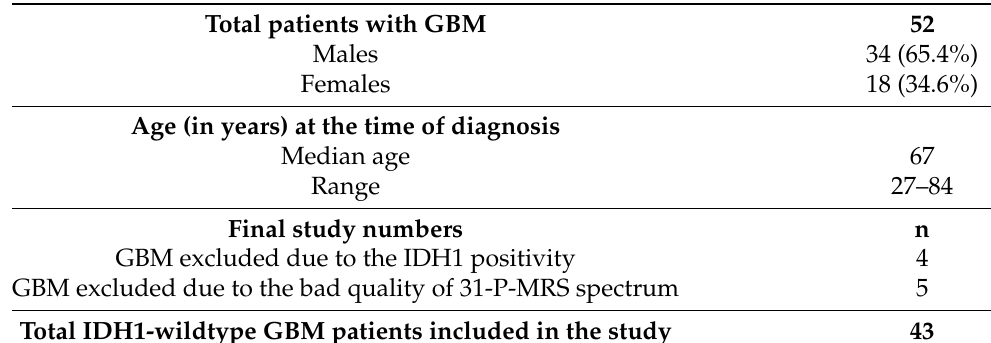
Table 1. Patient characteristics.